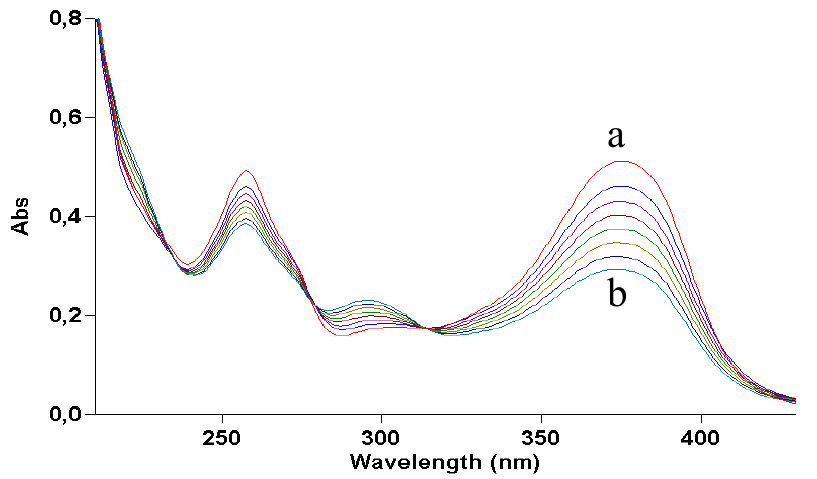
Figure 2. UV absorption spectra of a 2 × 10 − 5 M ethanol solution of quercetin irradiated with increasing doses of UVA. Curve a, dark; curve b, 70 J/cm 2